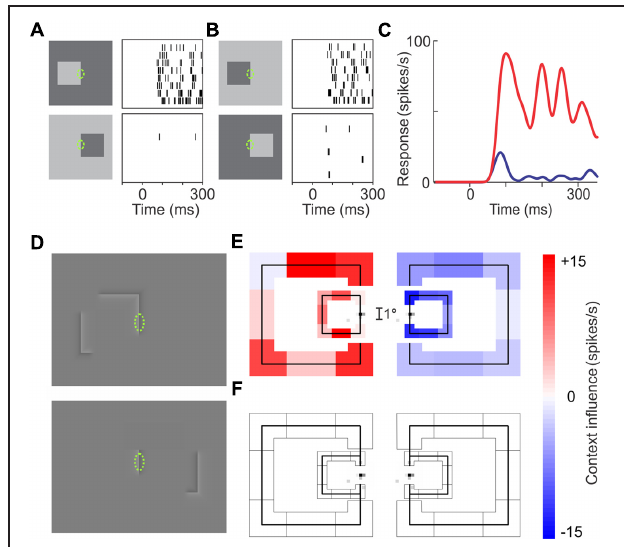
FIGURE 1 | Border ownership selectivity. (A–C) Responses of an example V2 neuron. Rows of tics in (A,B) represent repeated responses to the stimuli shown on the left. (A) The responses to the right-hand edge of a bright square (top) are much stronger than the responses to the left-hand edge of a dark square (bottom) despite stimuli being identical in the receptive field (green ellipse, not part of display): the neuron is sensitive to the image context. (B) Same as (A) , but contrast reversed. Again, the cell responds more strongly when the square is to the left of the receptive field: the neuron prefers ‘left’ border ownership. (C) Average time course of the neuron’s firing rate for left (red) and right (blue) border ownership. Note divergence of curves right after response onset (68 ms after stimulus onset in this neuron). (D–F) Demonstration of the range of context integration. A V2 Neuron was examined with edges as in (A) , but with contour-defined squares where luminance variations were confined to a narrow seam at the contours (D) . The contours were broken up into eight fragments (four edges and four corners); one edge was placed over the receptive field, while the seven ‘contextual’ fragments were presented randomly in all possible combinations. (E) The influence of each of the contextual fragments on the responses, as determined by regression analysis. Colored shading represents the regression coefficients, red indicating enhancement, blue, suppression. Results are shown separately for left and right locations of square, and for two sizes of square (3 ◦ and 8 ◦ visual angle). The small gray specks on the test edge show the map of the neuron’s classical receptive field determined with flashing bars. The small size of this near-foveal receptive field contrasts with the large range of context integration: nearly all contour fragments to the left of the receptive field enhanced the responses, whereas contour fragments to the right suppressed them. (F) The result of presenting the same contextual fragments as in (E) , but without the edge in the receptive field: the contextual fragments alone produced no response. (Modified from Zhang and von der Heydt,